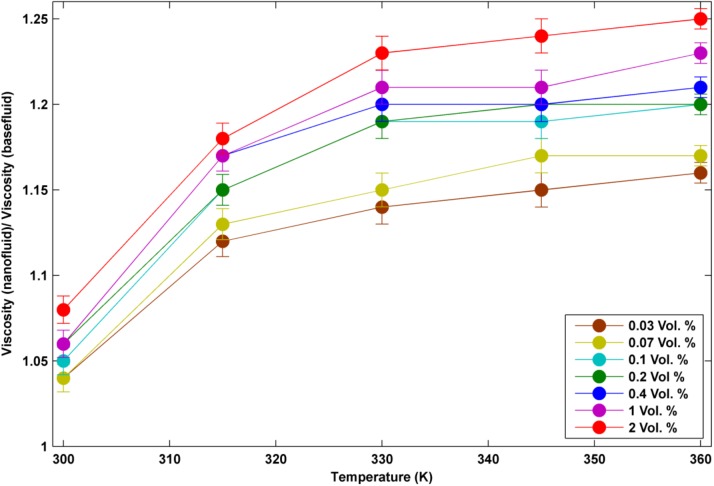
μnf/μbf in different temperatures.